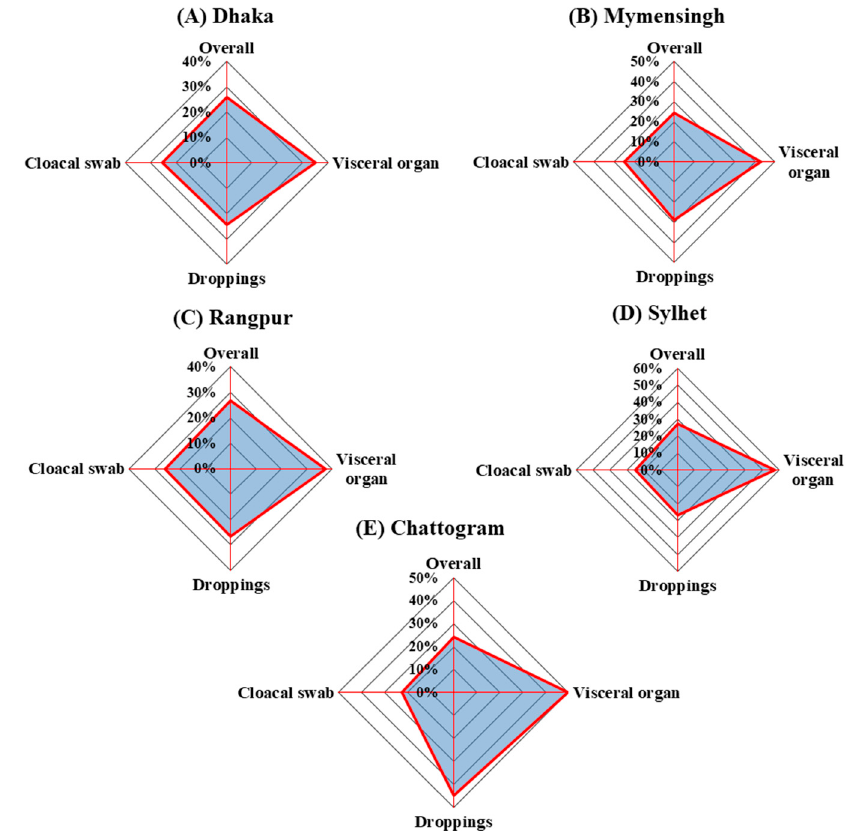
Figure 2. Occurrence of Salmonella Gallinarum in different samples (cloacal swab ( n = 535), visceral organ ( n = 50) and drooping ( n = 180)) collected from 12 layer flocks of five divisions: ( A ) Dhaka, ( B ) Mymensingh, ( C ) Rangpur, ( D ) Sylhet, and ( E ) Chattogram. Overall occurrence of Salmonella Gallinarum was estimated as 25.9%, 24.6%, 26.8%, 27.4%, and 24.4% in Dhaka, Mymensingh, Rangpur, Sylhet, and Chattogram divisions,